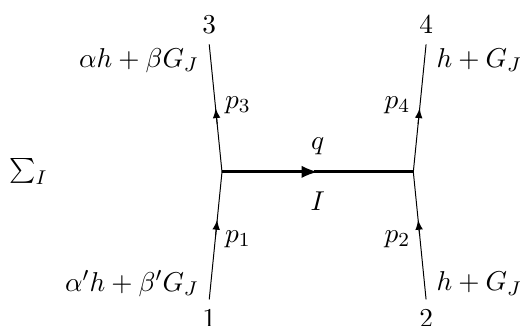
Figure 9 . Graviton interference bound: in-states are linear combinations of G J with J ≥ 3 and the graviton h